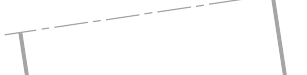
Figure 17. Path defined in post-processing.